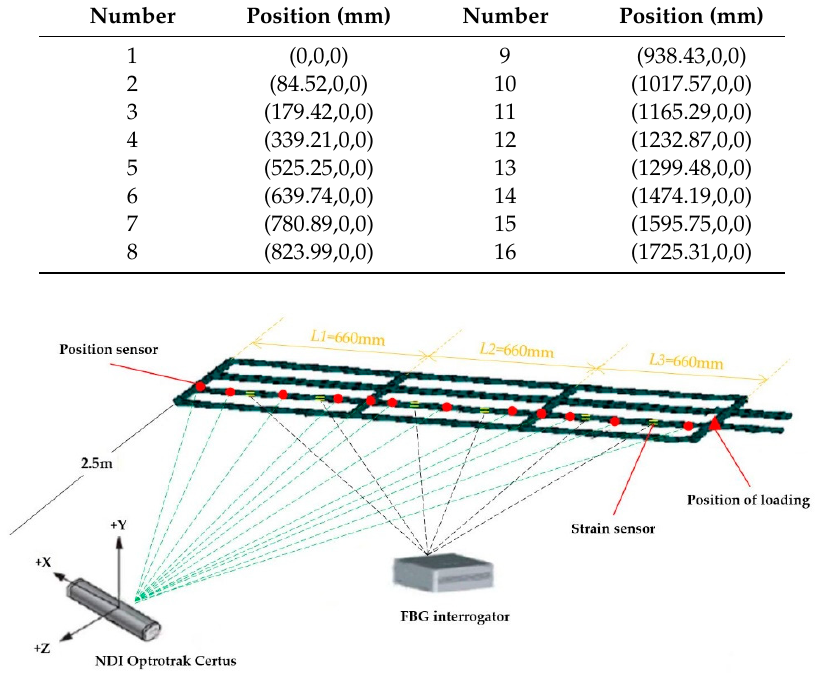
Figure 6. Experimental system.